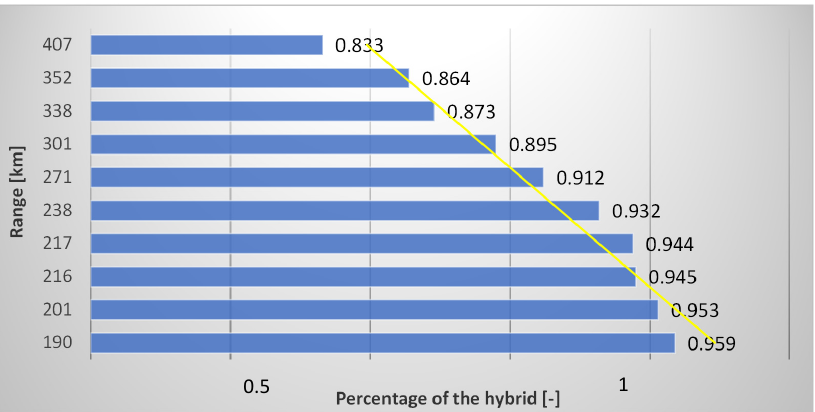
Figure 5. Percentage values of the hybrid drive for individual range distances. Source: Authors.